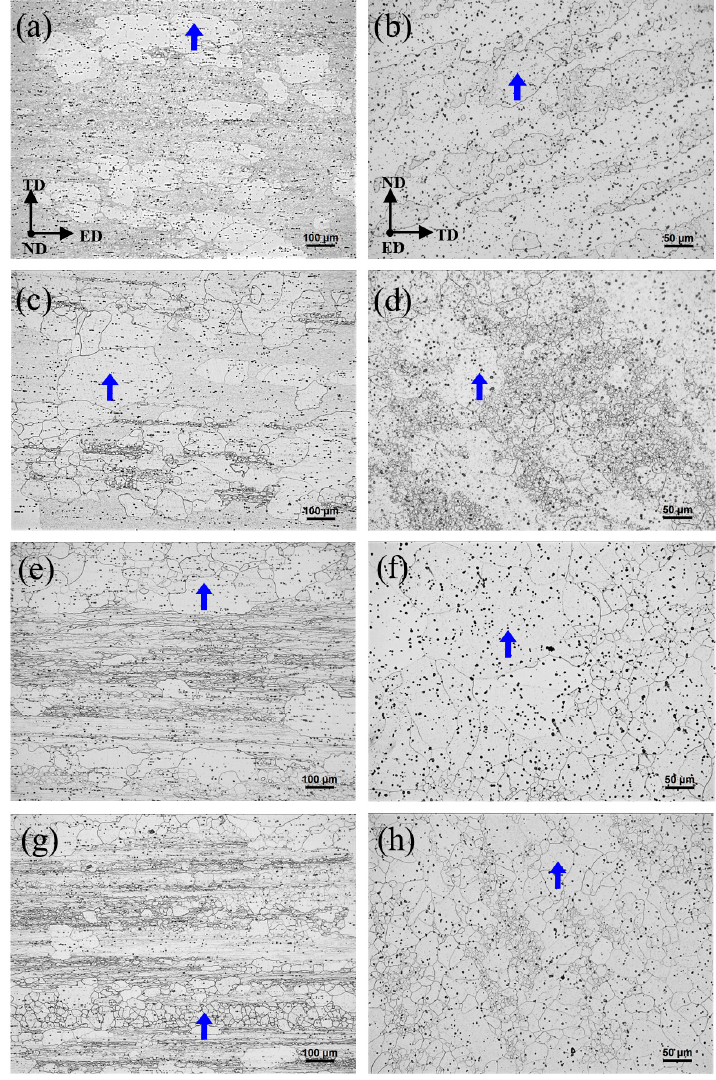
Figure 5. Microstructure of the extruded alloys: ( a , b ) λ = 7, ( c , d ) λ = 13, ( e , f ) λ = 21, ( g , h ) λ = 30.